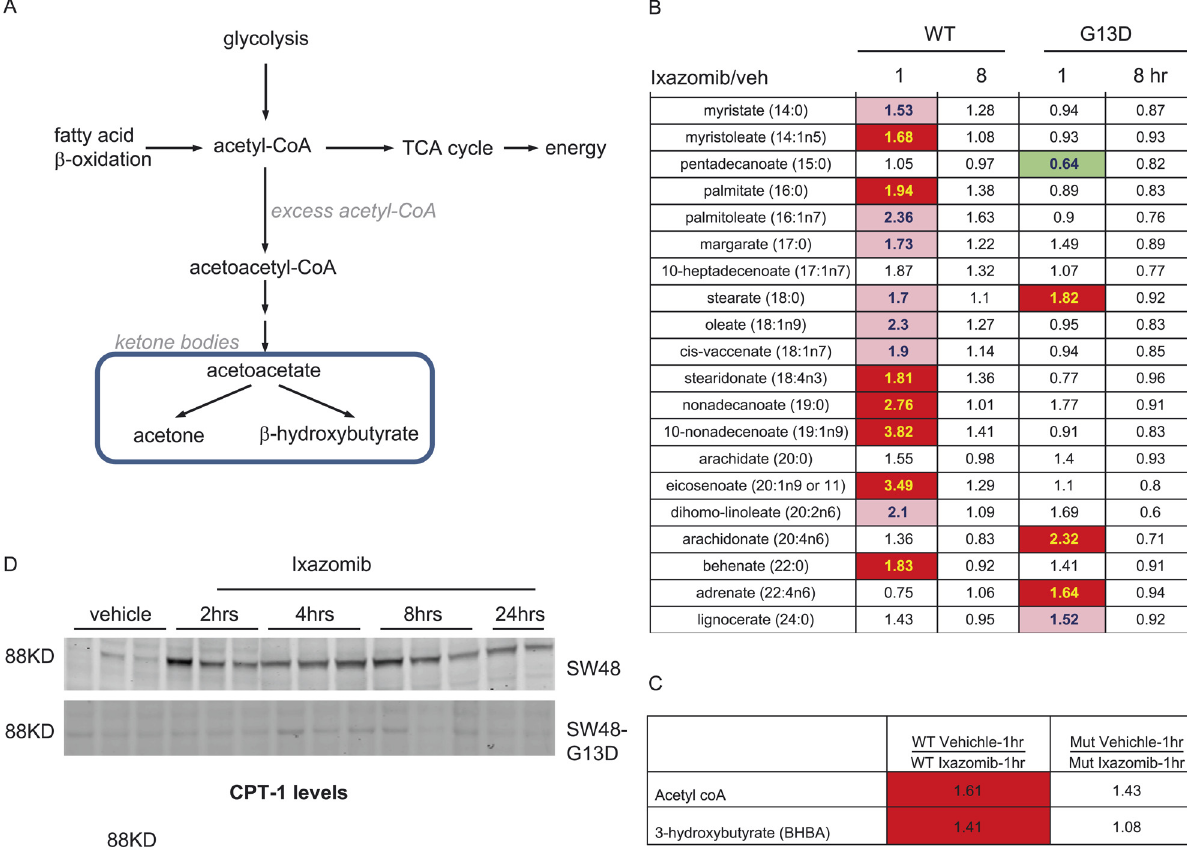
Fig 6. Induction of β -oxidation by ixazomib treatment in SW48 WT tumors. metabolites involved in fatty acid beta oxidation pathway. (A) Table summarizing free fatty acids in tumor samples. The numbers indicate the fold change in drug treated tumors over vehicle treated tumors at 1 and 8hrs time points. Each data point represents an average of tumors from five different animals. Table summarizing the levels of acetyl Co-A and 3 Hydroxy butyrate at 1hr after ixazomib treatment. The numbers indicate fold change in ixazomib treated tumors over vehicle treated tumors, n = 5 per data point. Changes in CPT-1 protein level following ixazomib treatment in SW48 and SW48-G13D tumors. The vehicle samples were collected at 4hrs after dosing and the ixazomib treated samples were collected at different time points (as indicated in the figure) after the drug treatment. The color coding is as described in Fig 4.